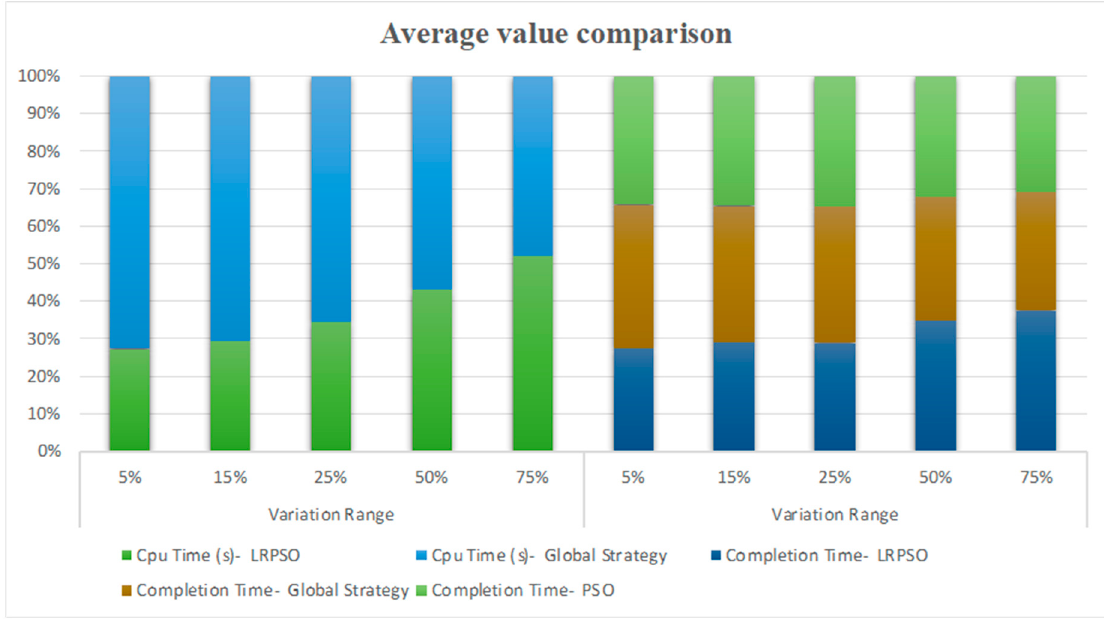
Figure 6. Comparison chart of average result values.